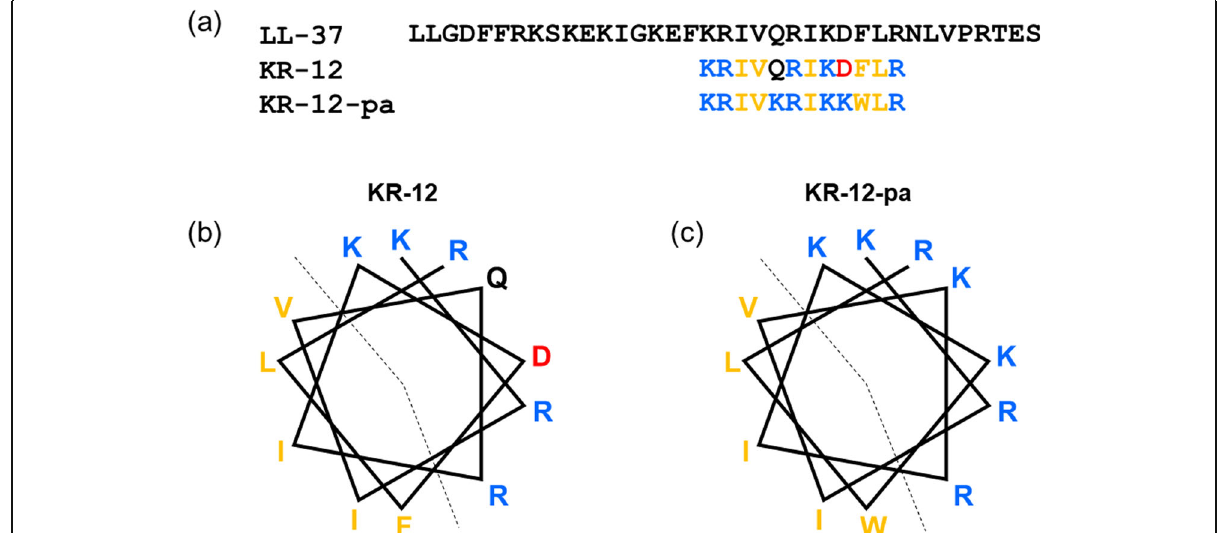
Fig. 1 Primary sequences and helical wheel diagrams of LL-37, KR-12, and KR-12-pa. Positively charged residues are in blue. Negatively charged residues are in red. Hydrophobic residues are in yellow